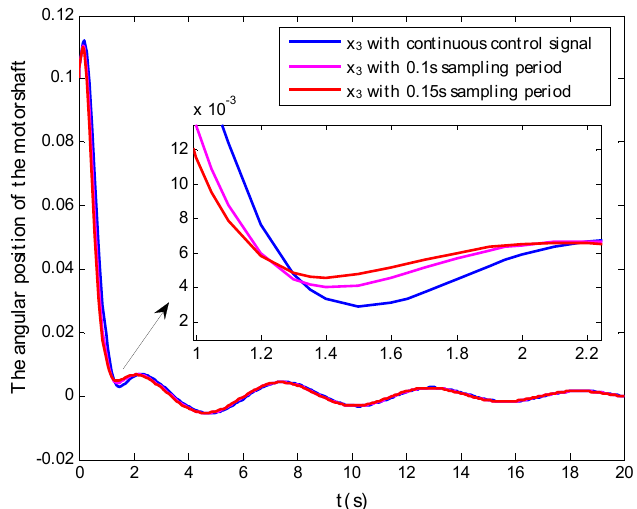
x with different sampling periods.